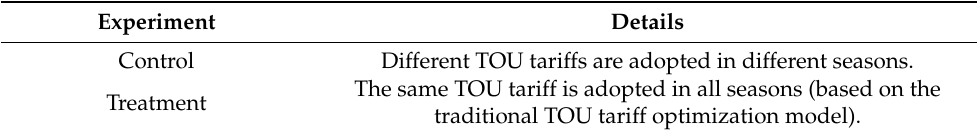
Table 8. The comparative tests of the TOU optimization design model. Experiment Details Control Different TOU tariffs are adopted in different seasons. The same TOU tariff is adopted in all seasons (based on Treatment the traditional TOU tariff optimization model).